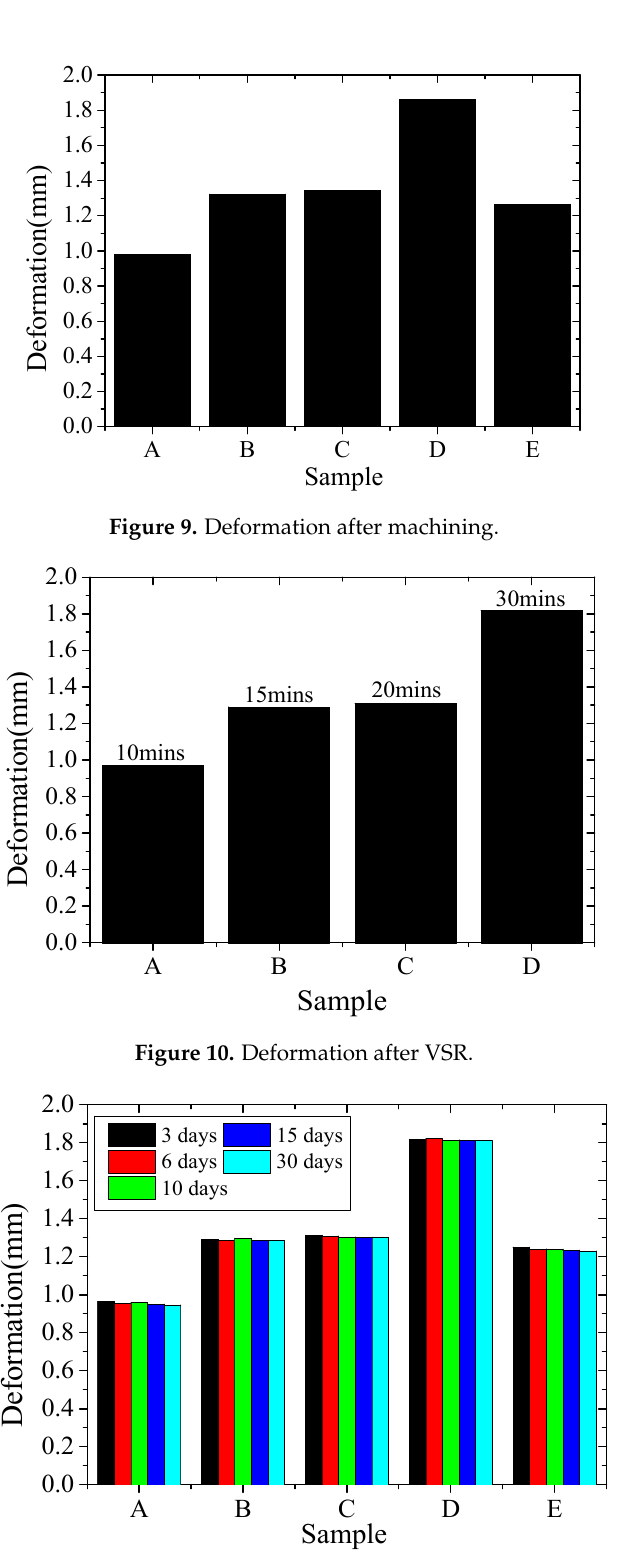
Figure 11. Deformation of A–E after natural aging.